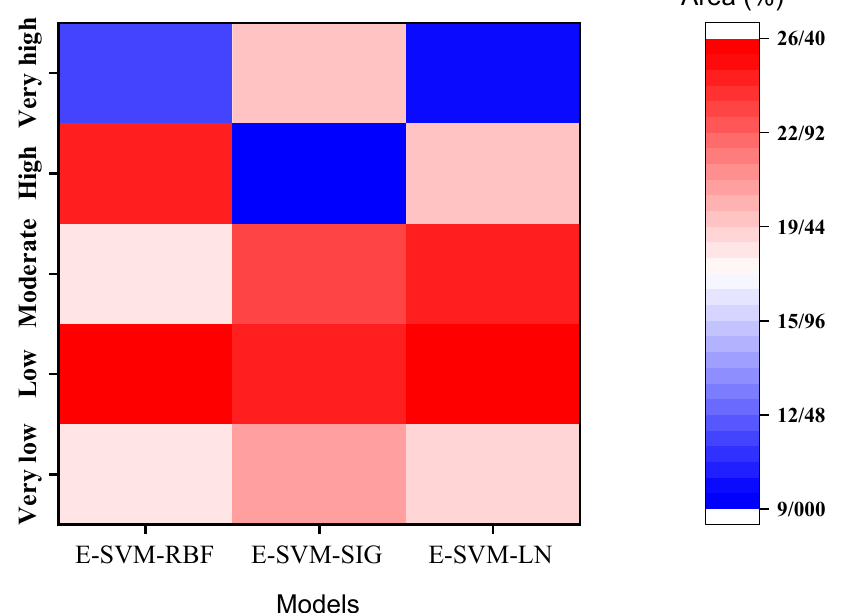
Figure 6. Percentage of karst groundwater potential classes in the study area.